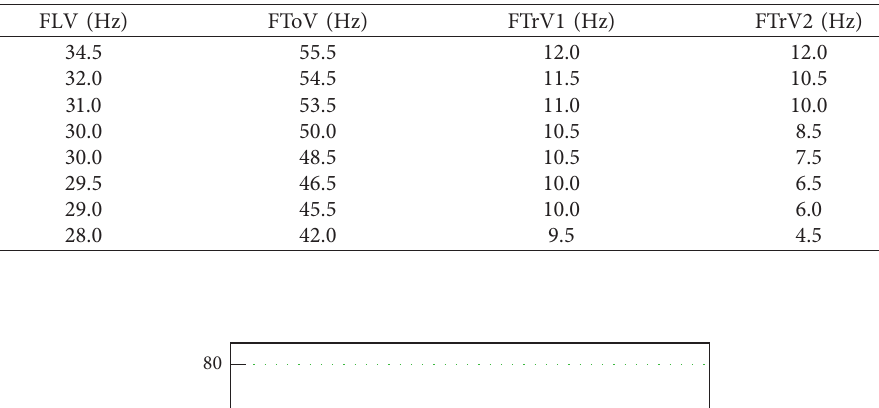
Table 1: Rock natural frequency and measurement conditions.